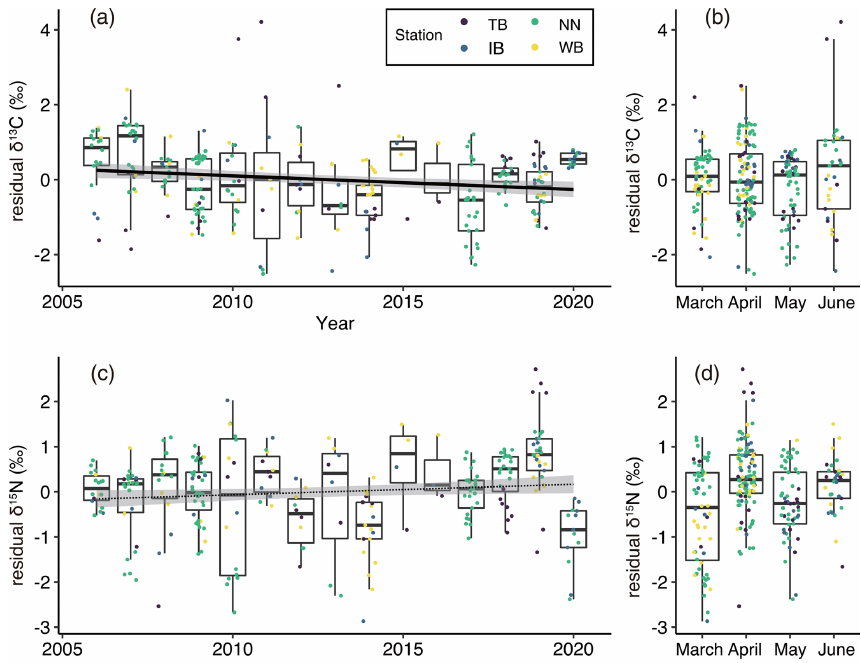
Figure 5. (a) Interannual and (b) monthly variations of residual δ 13 C (residuals of δ 13 C in the GLM) values and (c) interannual and (b) monthly variations of residual δ 15 N values. Box plots show the medians (horizontal lines within boxes), upper and lower quartiles (boxes), and quartile deviations (bars). Small points are raw data points, and the colors of points indicate stations. The black lines and gray shading (a, c) indicate linear regression lines and 95% confidence intervals, respectively. The coefficient of regression line was significantly different from 0 between residual δ 13 C and year (solid line) but not between residual δ 15 N and year (dotted line).